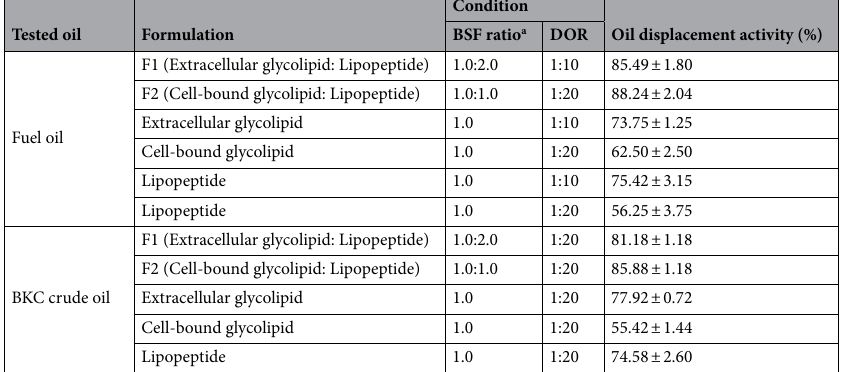
Table 1. Comparison of oil displacement activities of biosurfactant-based dispersants and individual biosurfactants under various conditions. a BSF ratio is the mass ratio of extracellular/cell-bound glycolipid to